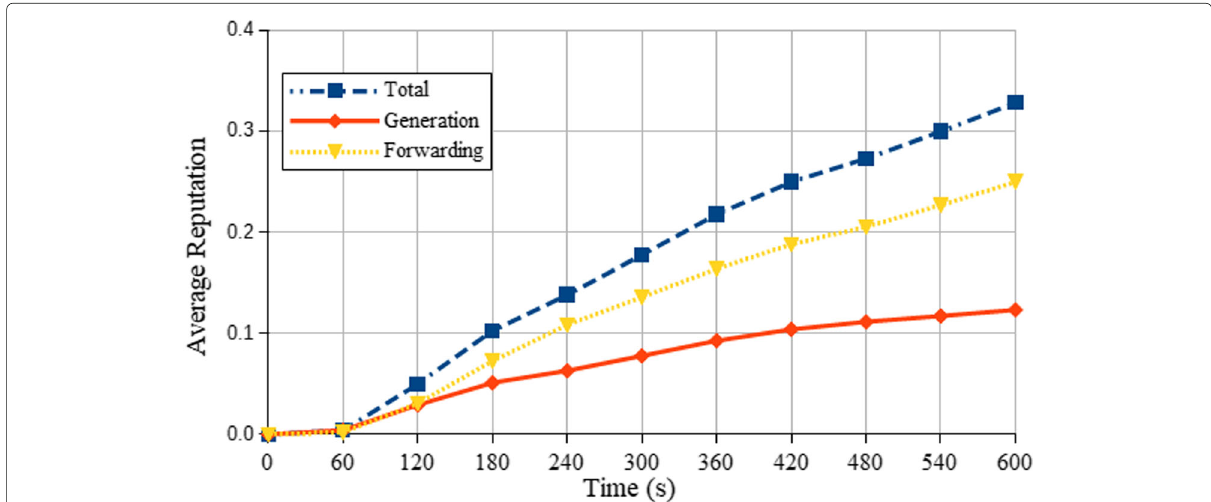
the scenario with 25% of the MV which are similar to the results of the scenario with 12.5% of the MV. The results of AR for 50% of the MV are shown in Fig. 9. The results for the generation of messages are negative because the number of vehicles generating fake